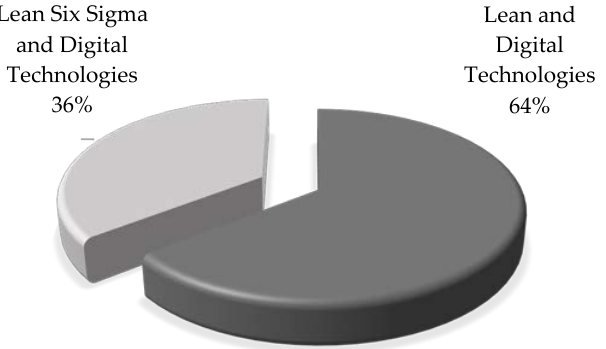
Figure 3. Main interventions supported by digital technologies.